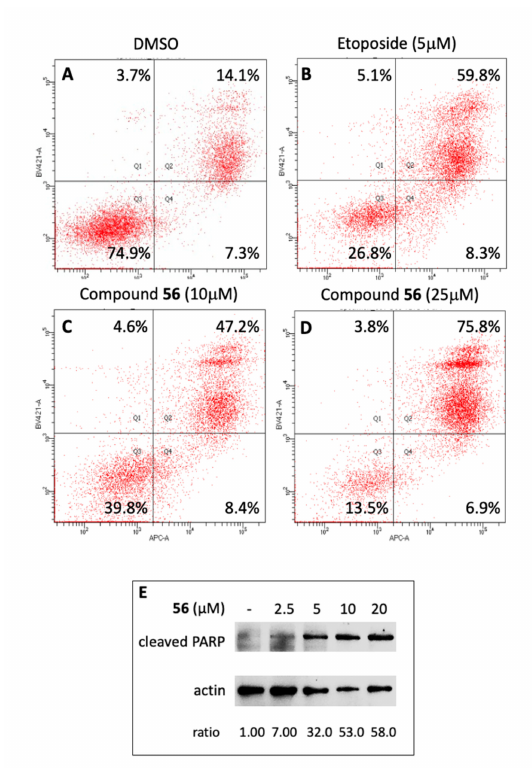
Figure 3. Induction of apoptosis upon treatment of OCI cells with 56 . ( A – D ) Annexin V staining, ( E ) PARP cleavage. ( A ) Control cells treated with DMSO; ( B ) Cells treated with etoposide (5 µ M); ( C ) Cells treated with 10 µ M 56 ; ( D ) Cells treated with 25 µ M 56 ; Apoptotic cells appear in the upper right-hand quadrant ( A – D ) ( E ) Induction of PARP cleavage (normalized ratio = cleaved PARP / actin).